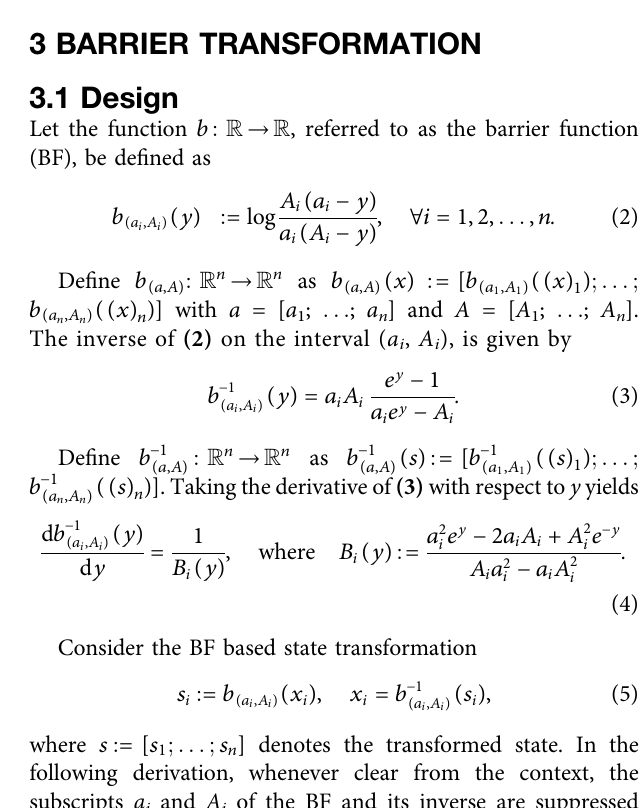
Frontiers in Robotics and AI |